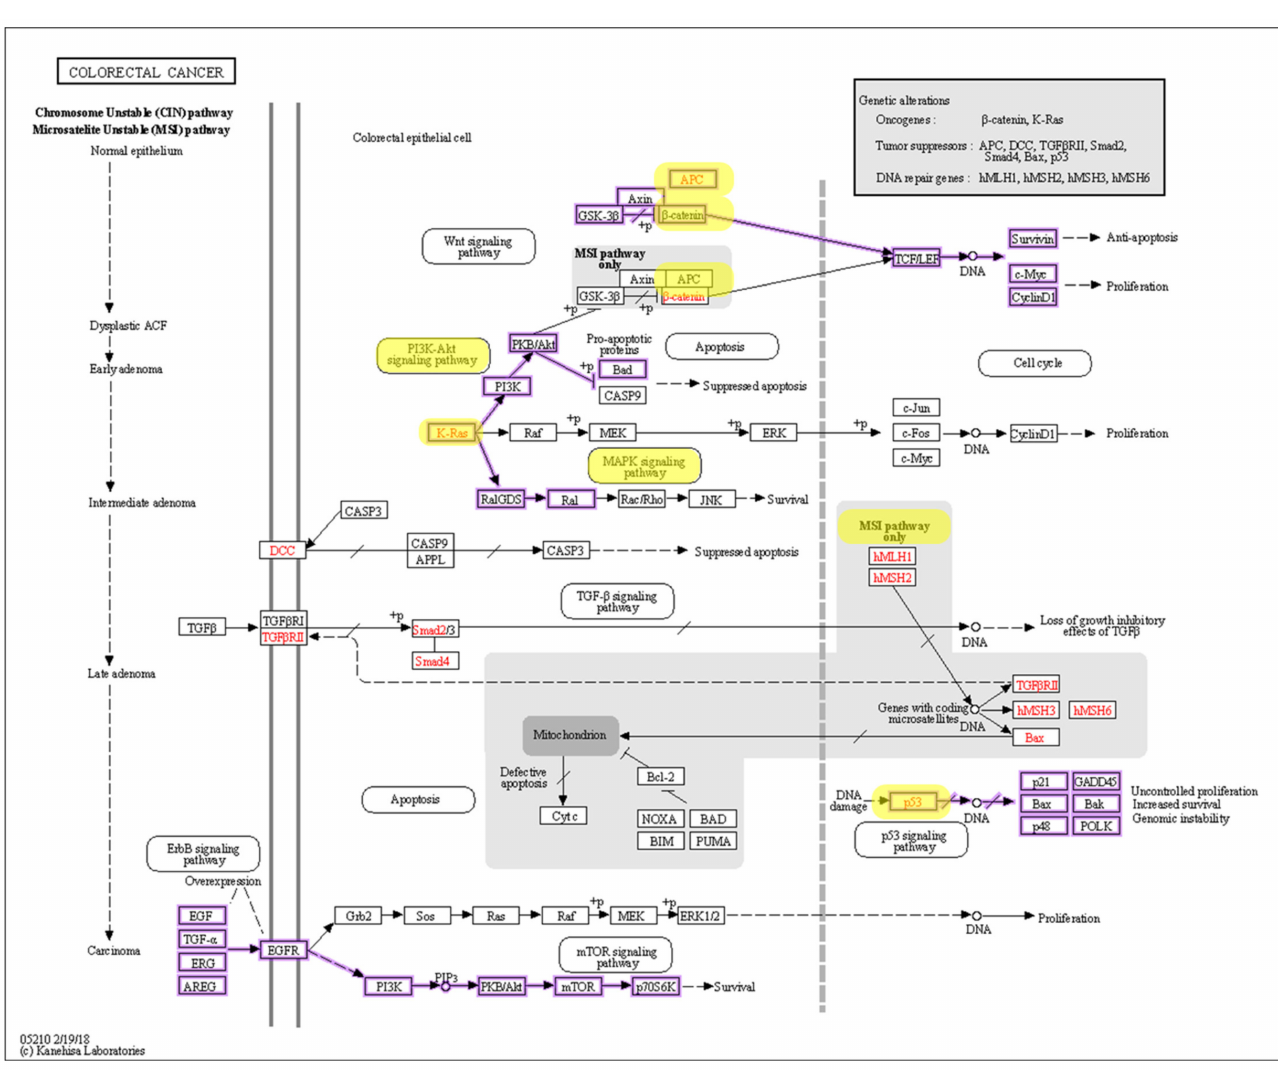
Figure 3. Colorectal cancer pathways. Molecules, pathways, and interactions implicated in CRC are highlighted. Reproduced from [49] with